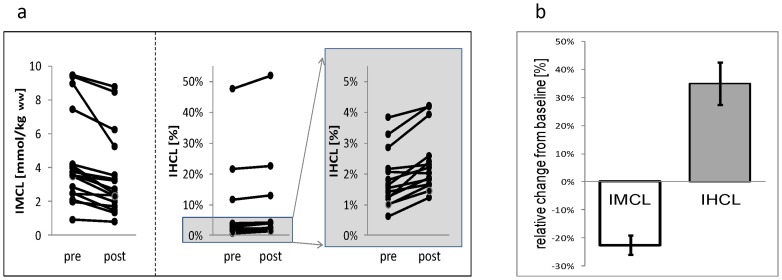
Effect of aerobic exercise on intramyocellular (IMCL) and intrahepatocellular lipids (IHCL).

Figure 3a
 Individual IMCL and IHCL measurements before (pre) and after (post) a 2h-aerobic exercise at 50% VO2max of each subject. A significant decrease in IMCL (p<0.005) and a significant increase in IHCL (p<0.002) was documented. The diagram on the far right is a blow up of the IHCL data depicted in the middle part to show the changes in IHCL for volunteers with low IHCL levels.
Figure 3b
 Changes (mean ± 1 SEM) of IMCL and IHCL (in % from baseline) following a 2h-aerobic exercise at 50% VO2max.